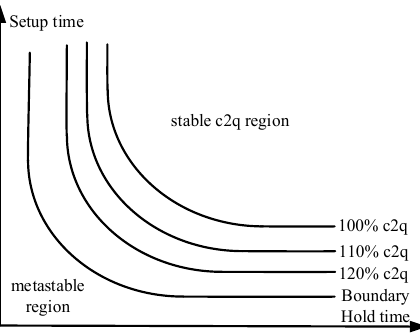
Figure 3. Clock ‐ to ‐ q delay with respect to setup and hold constraint pairs. Figure 3. Clock-to-q delay with respect to setup and hold constraint pairs.